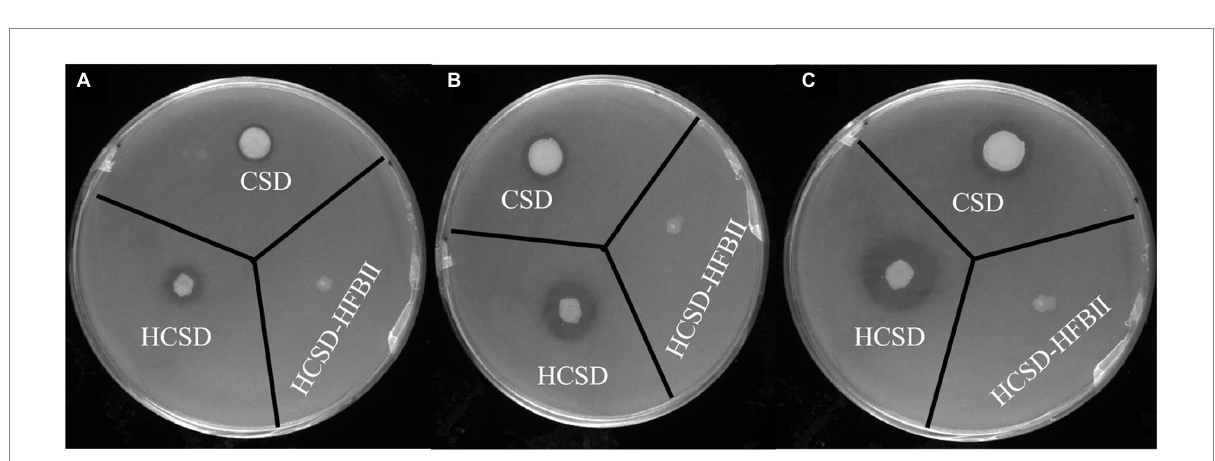
FIGURE 3 Halo formation of PETase-displaying E. coli BL21(DE3) harboring plasmid pET30a (+): HCSD , pET30a (+): CSD and pET30a (+): HCSD-HFBII on tributyrin agar plate incubated at 18 ° C after (A) 1 day; (B) 3 days; (C) 5